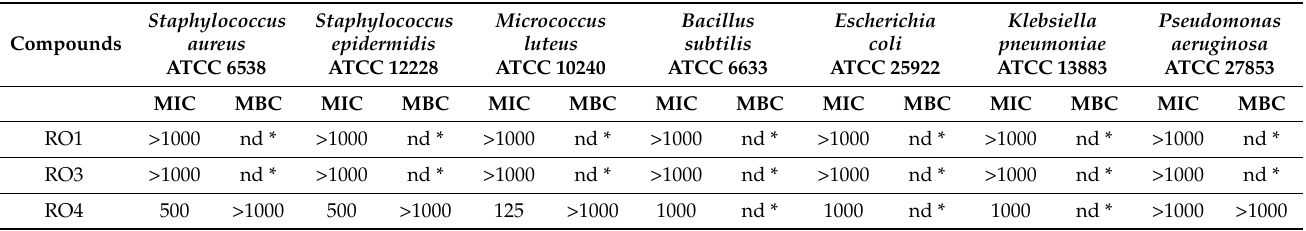
Table 1. Activity of the newly synthesized Schiff bases against reference strains of bacteria expressed as the values of the minimal inhibitory concentration (MIC; µ g/mL) and the minimal bactericidal concentration (MBC; µ